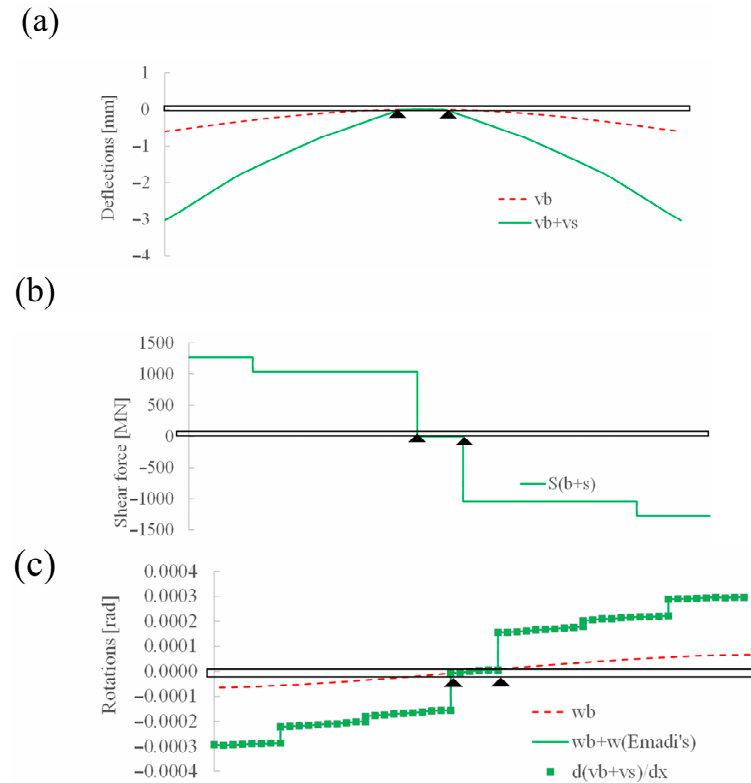
Figure 13. Yunbao bridge analysis: ( a ) vertical deflections, ( b ) shear diagram, and ( c ) rotations with and without shear effects.